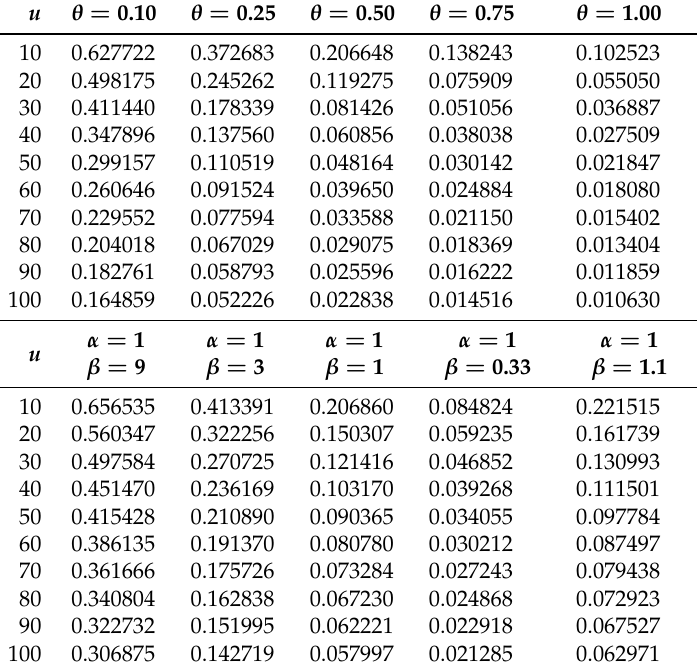
Table 4. Classical ruin probabilities for Pareto distribution (above) with m = 1 and different values of the premium loading factor θ . Probabilities based on expression (17) and Beta mixing distribution (below).